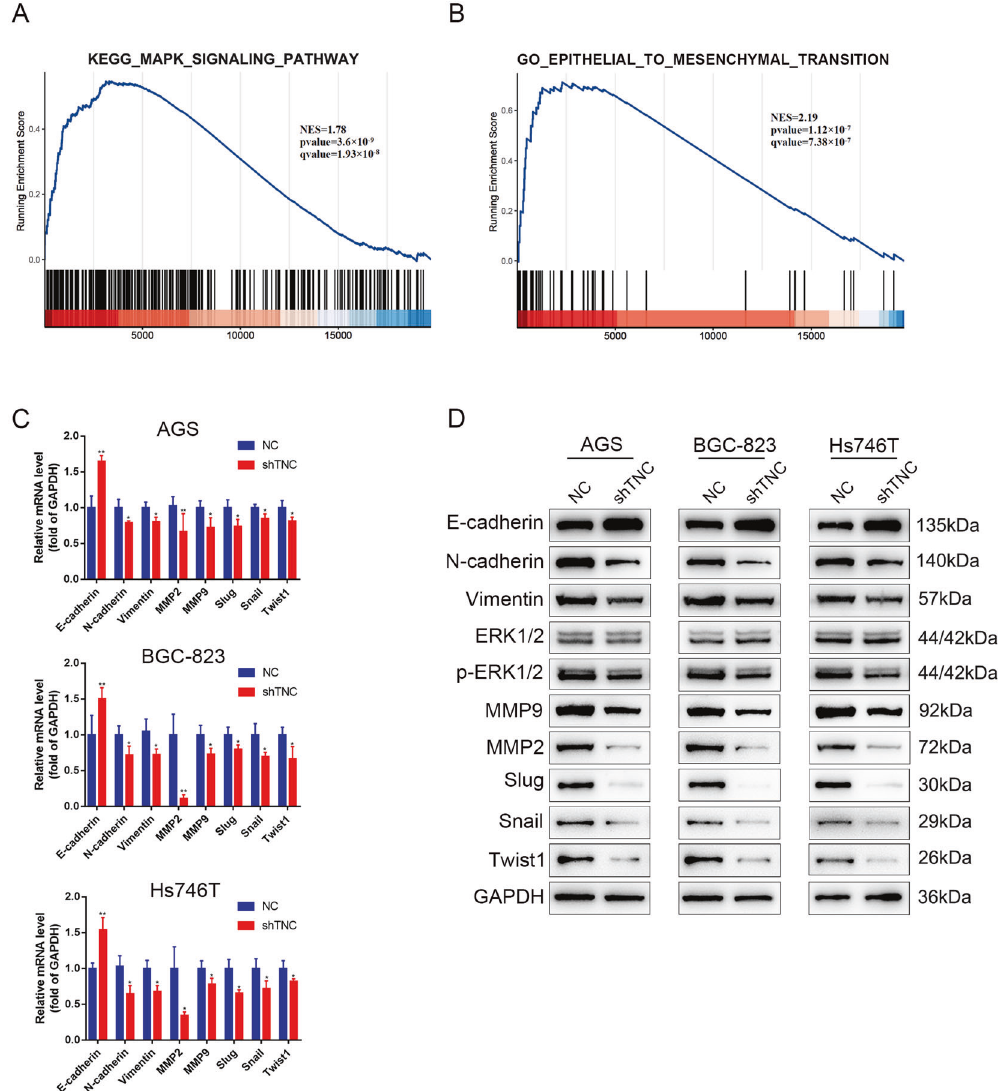
Fig. 4 TNC correlated with ERK pathway and EMT process. A Gene Set Enrichment Analysis evaluating TNC expression and the MAPK_SIGNALING pathway in gastric cancer. B Bioinformatic analysis showed that TNC expression was in accordance with EMT process; qPCR ( C ) and western blot analysis ( D ) of ERK and EMT markers expression in AGS, BGC-823 and Hs746T cells transfected with TNC